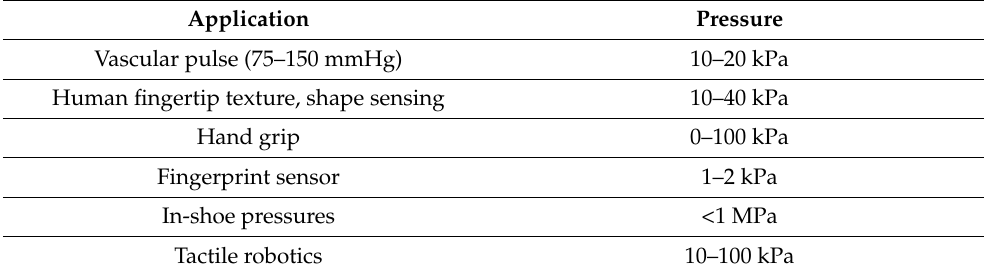
Table 4. Common applications of flexible pressure sensing and ranges